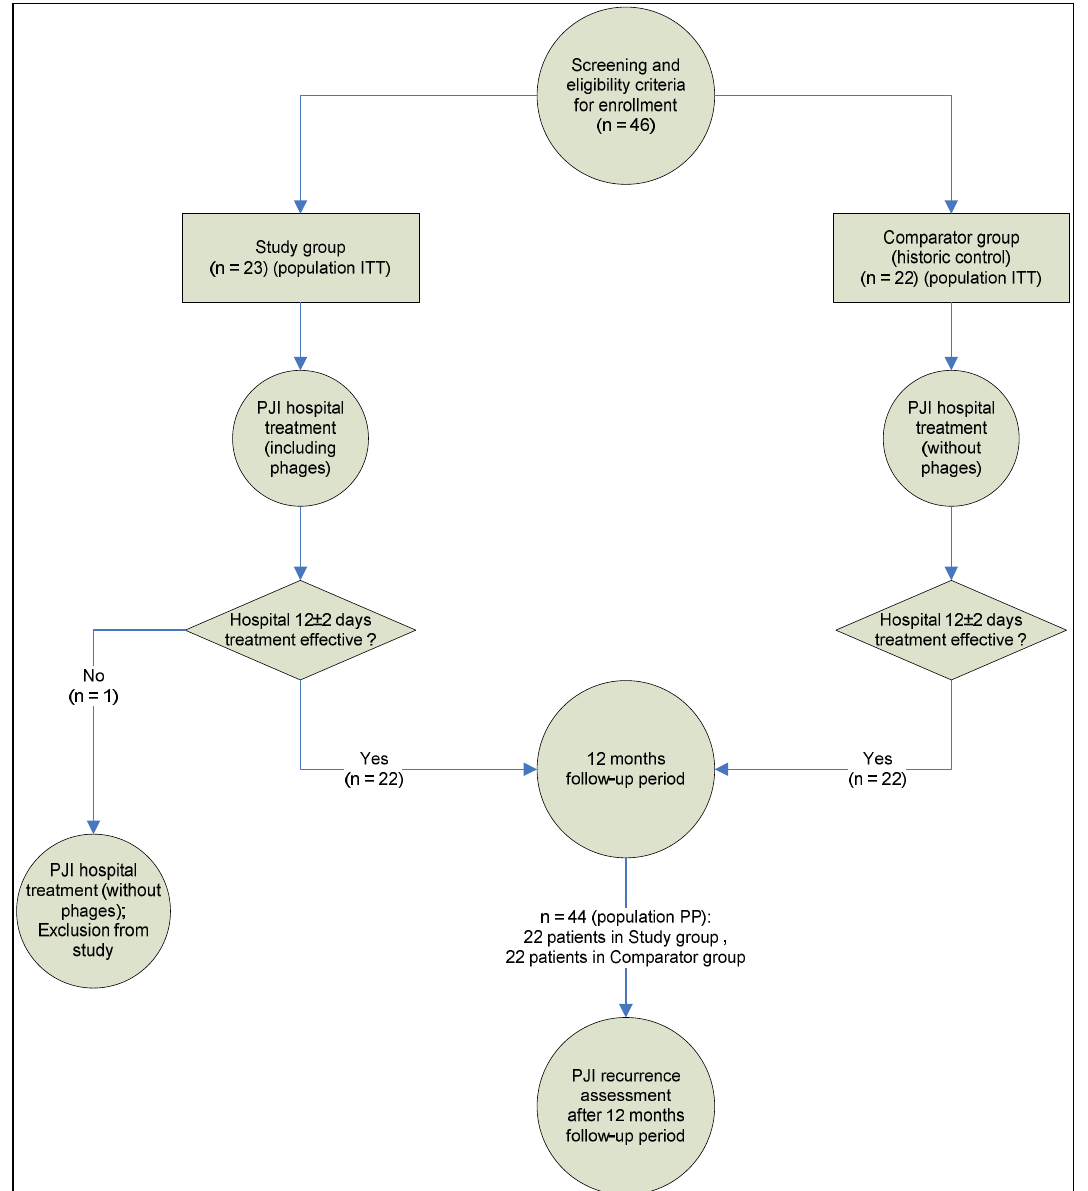
Figure 1. Study design and patient disposition.